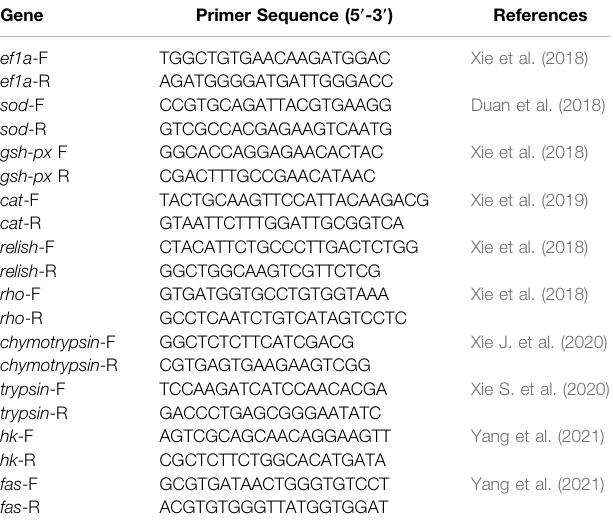
TABLE 2 | Sequences of primers used for real-time quantitative PCR.